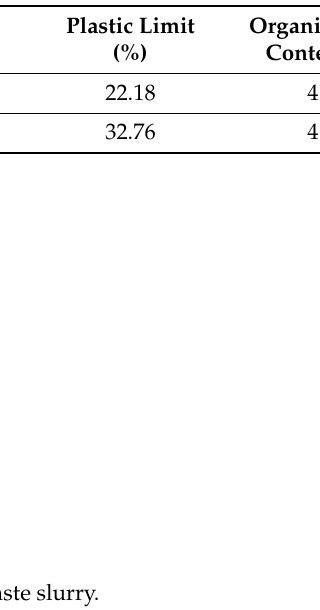
Table 2. Chemical properties of PAM used in this